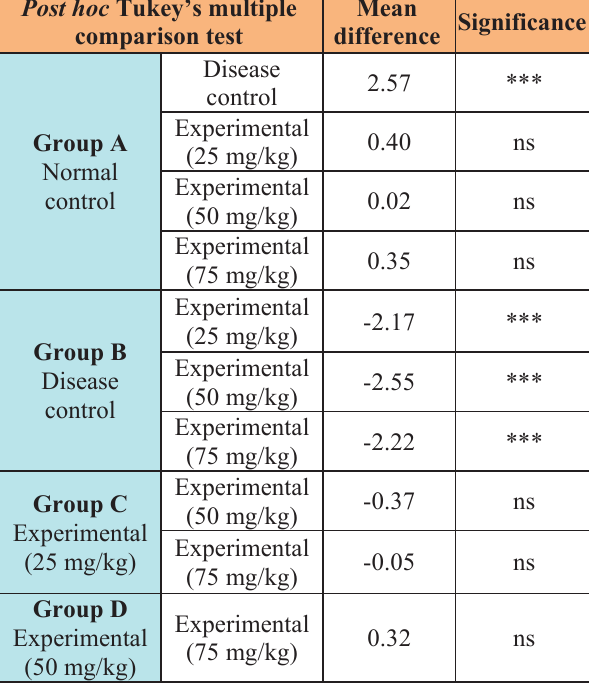
Table-2: Comparison of effect of apple peel extract, carboplatin and carboplatin plus 3 different doses of apple peel extract on red blood cell count in mice by post hoc Tukey’s test (n=8) ns = not significant, * = p value < 0.05, ** = p value < 0.01, *** = p value <0.001